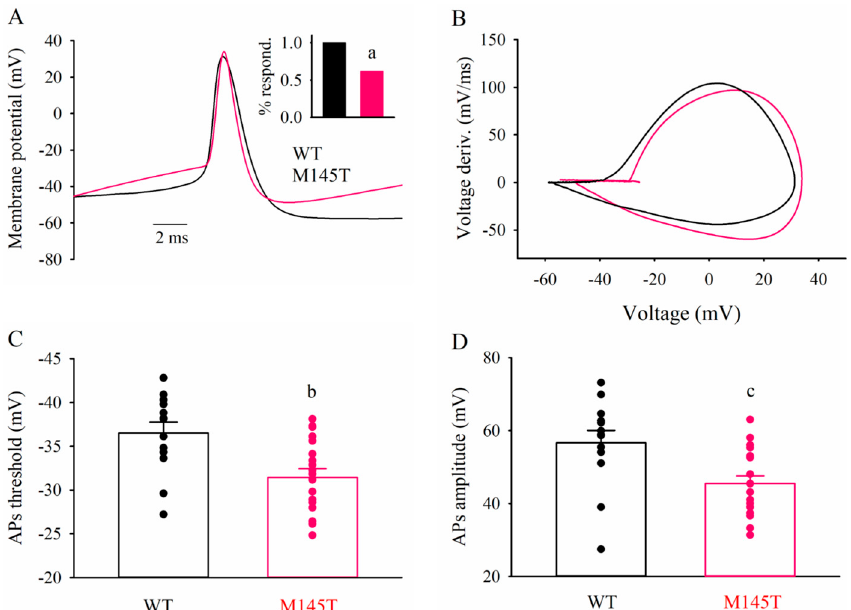
Figure 7. SCN1A M145T idNs exhibit depolarized action potential (AP) threshold. ( A ) superimposed typical AP traces recorded from one WT and one M145T neuron (black and magenta traces, respectively). Inset: bar graphs representing the frequency of AP-firing cells (a, p = 0.004, Fisher Exact test). ( B ) superimposed phase-plane plot obtained from the two APs shown in ( A ). ( C ) bar graphs representing the mean AP threshold values averaged from 13 WT- and 19 SCN1A M145T idNs, as indicated. Circles indicate the AP threshold of individual cells (b, p = 0.003). ( D ) bar graphs representing the mean AP amplitude values. Same cells as in ( C ) (c, p = 0.006).